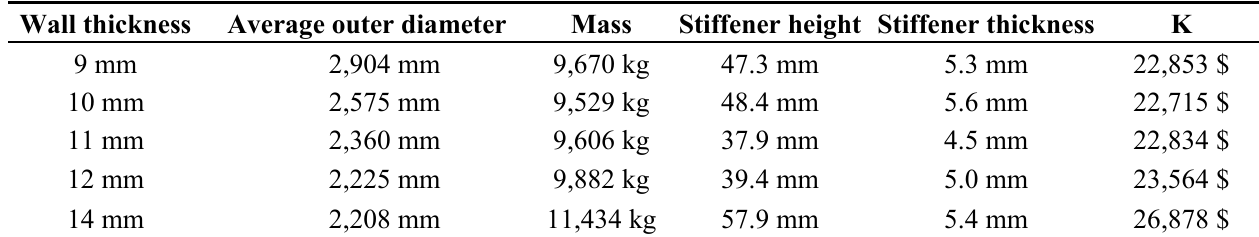
Table 7. Optimization results for the middle